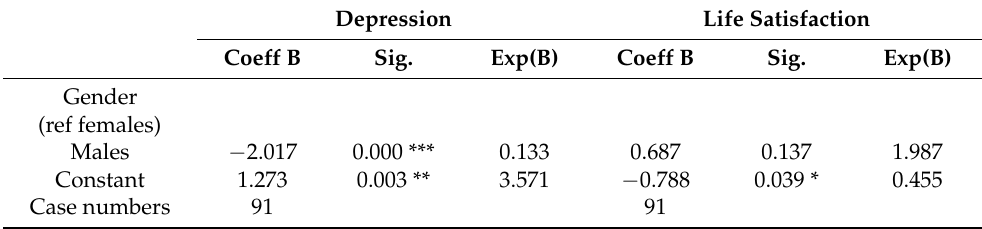
Table 4. Results of the logistic regression model on gender and depression and life